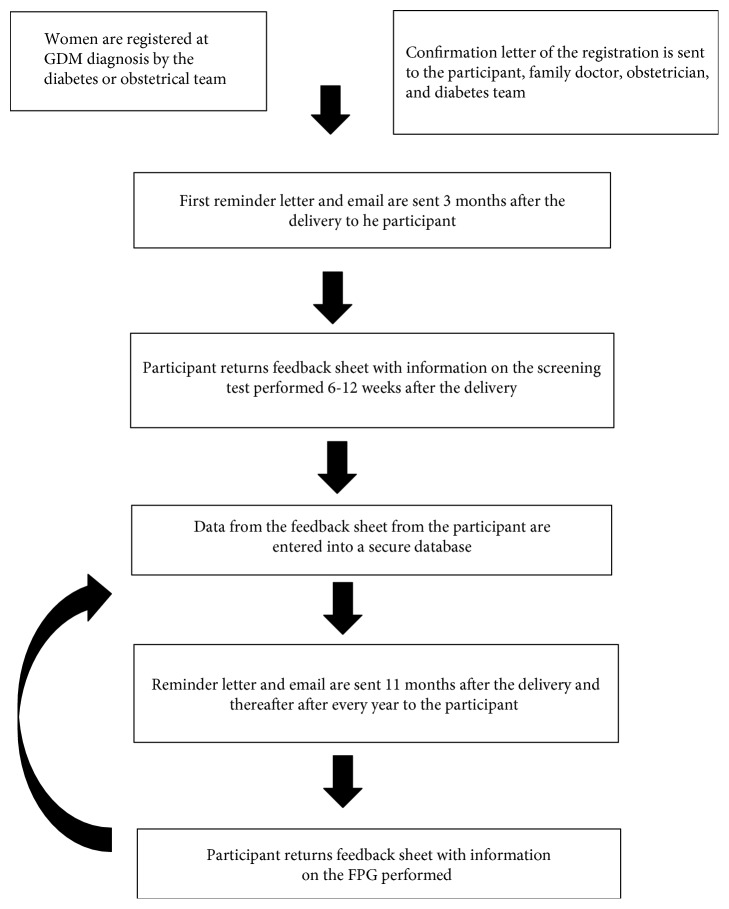
Overview of the recruitment and follow-up on the GDM recall register. GDM: gestational diabetes; FPG: fasting plasma glucose.